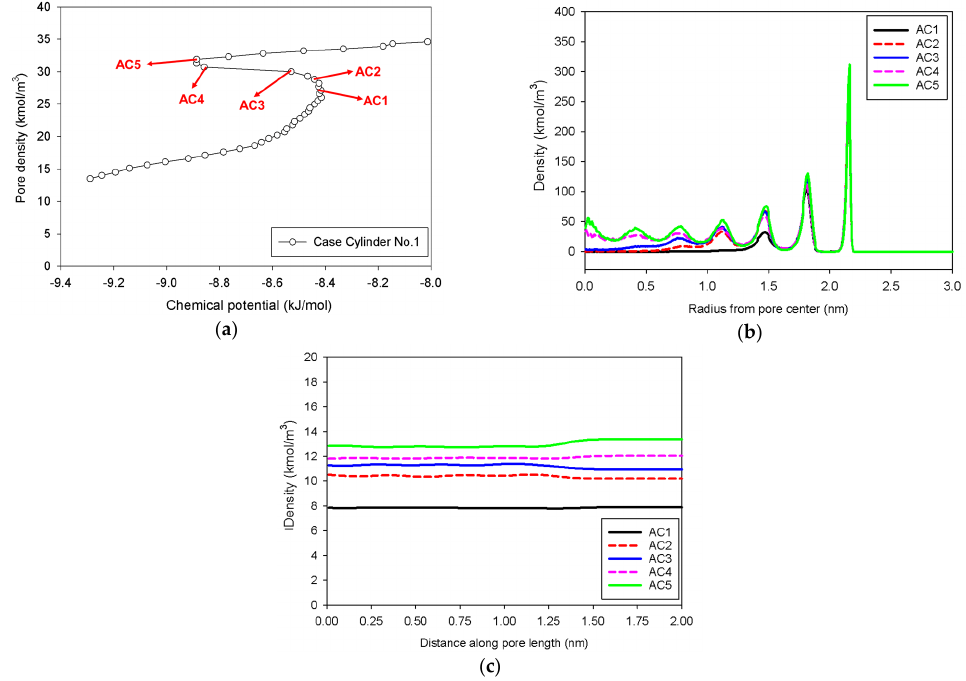
Figure 8. ( a ) Nitrogen adsorption isotherm in the infinite cylindrical pore of 5 nm in diameter at 77 K for Cylinder No.1, and its local density distributions ( b ) across pore radius and ( c ) along pore length.